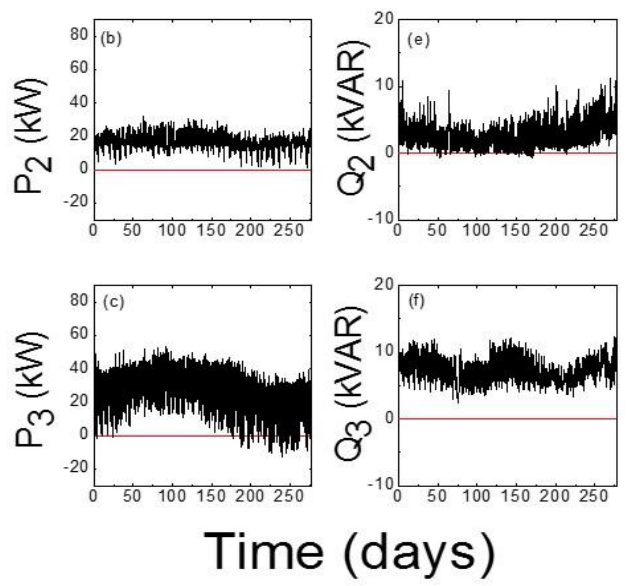
Figure 1. ( a ) Active power P 1 ; ( b ) active power P 2 ; ( c ) active power P 3 ; ( d ) reactive power Q 1 ; ( e ) reactive power Q 2 ; and ( f ) reactive power Q 3 .